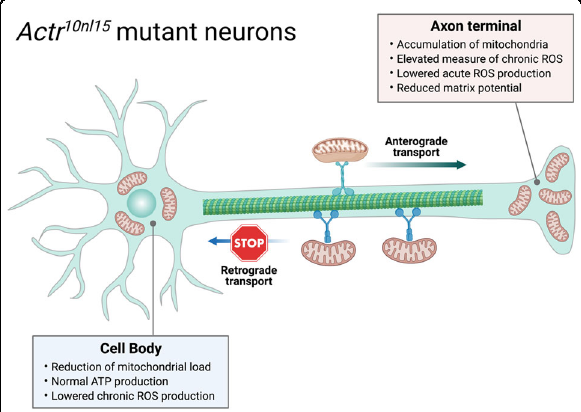
Fig. 1 Inhibition of mitochondrial retrograde transport results in an imbalanced mitochondrial load. (Created with